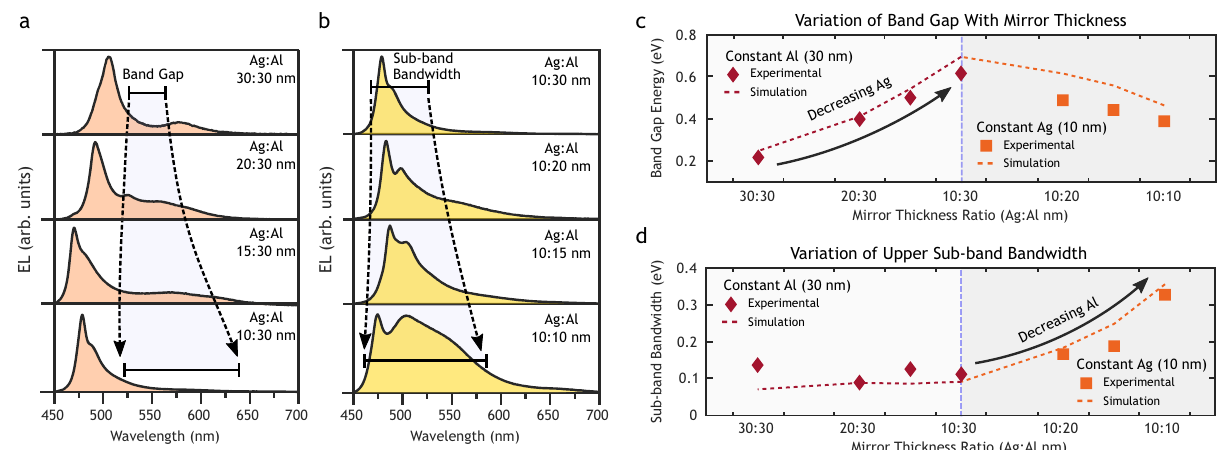
Fig. 4 Modulation of the photonic band gap by varying one set of mirror thicknesses. a Emission spectra from constant-thickness Al devices. The silver mirror thickness was reduced from 30 → 10 nm, keeping the Al mirrors fi xed at 30 nm. b Emission spectra from constant-thickness Ag devices. The aluminum thickness was reduced from 30 → 10 nm, keeping the Ag mirrors fi xed at 10 nm. The Ag thickness of 10 nm was selected to enable resolution of the peaks. c Modulation of the photonic band gap as a function of the silver and aluminum mirror thicknesses. The silver mirror thickness was found to strongly control the band gap energy. d Modulation of the sub-band state separation as a function of the silver and aluminum mirror thicknesses. While the silver mirror thickness was found to have little impact on the separation between states, decreasing the aluminum mirror thickness resulted in an increase in the state separation within the upper